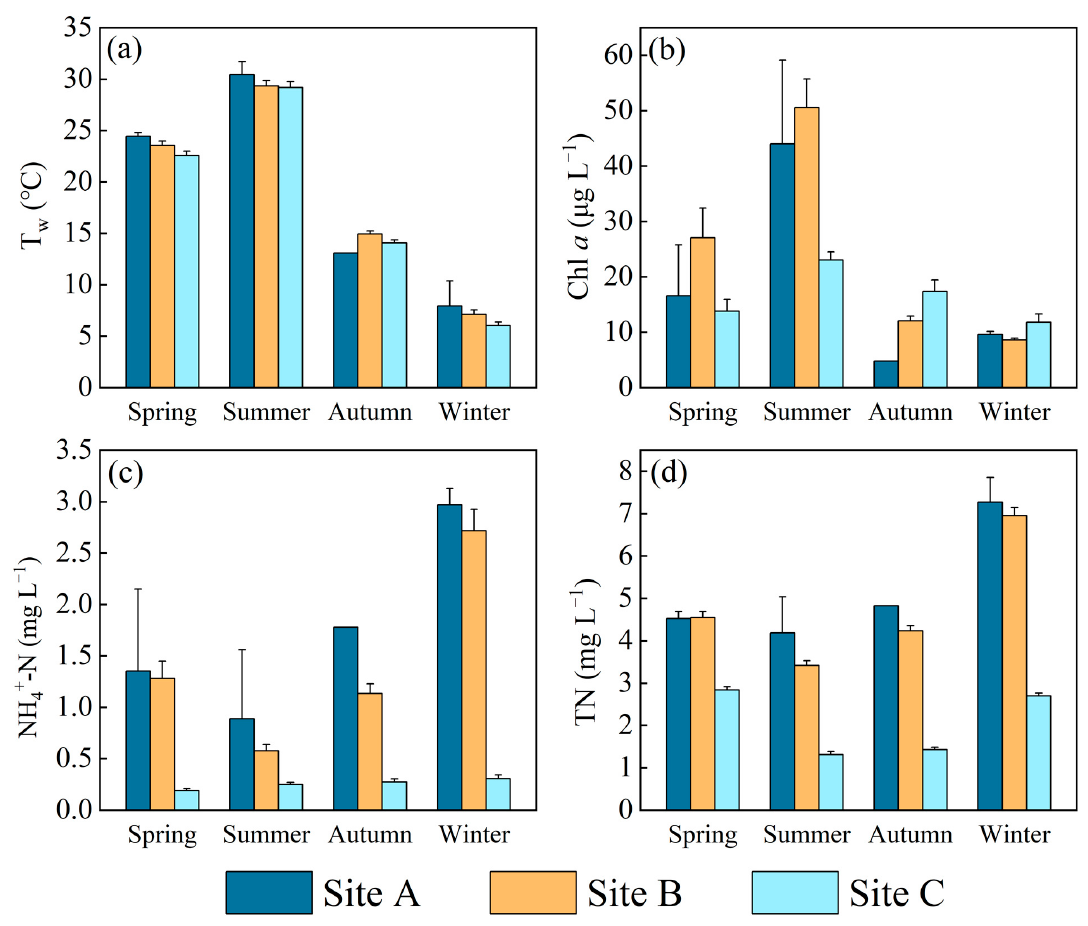
Figure 3. Seasonal variation in key environment variables (( a ) Temperture, ( b ) Chl a , ( c ) NH 4+ -N, ( d ) TN) at the three sampling sites (Site A, Site B, and Site C) during the sampling period.